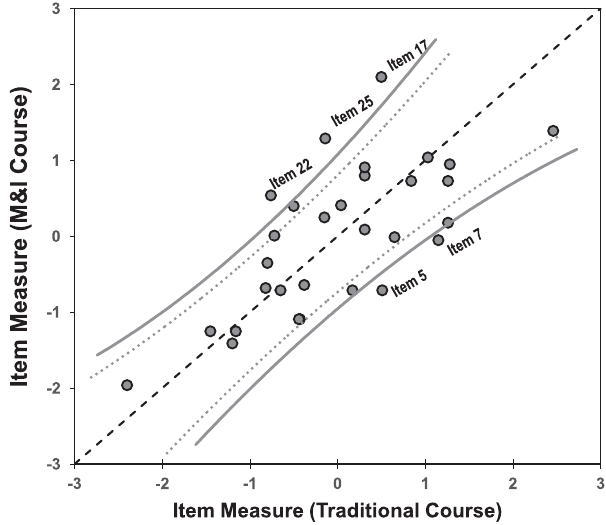
FIG. 4. A scatter plot of BEMA item difficulty estimates based, respectively, on data from the traditional and M&I courses. Dotted curves are 95% confidence bands, solid curves are 99% confidence